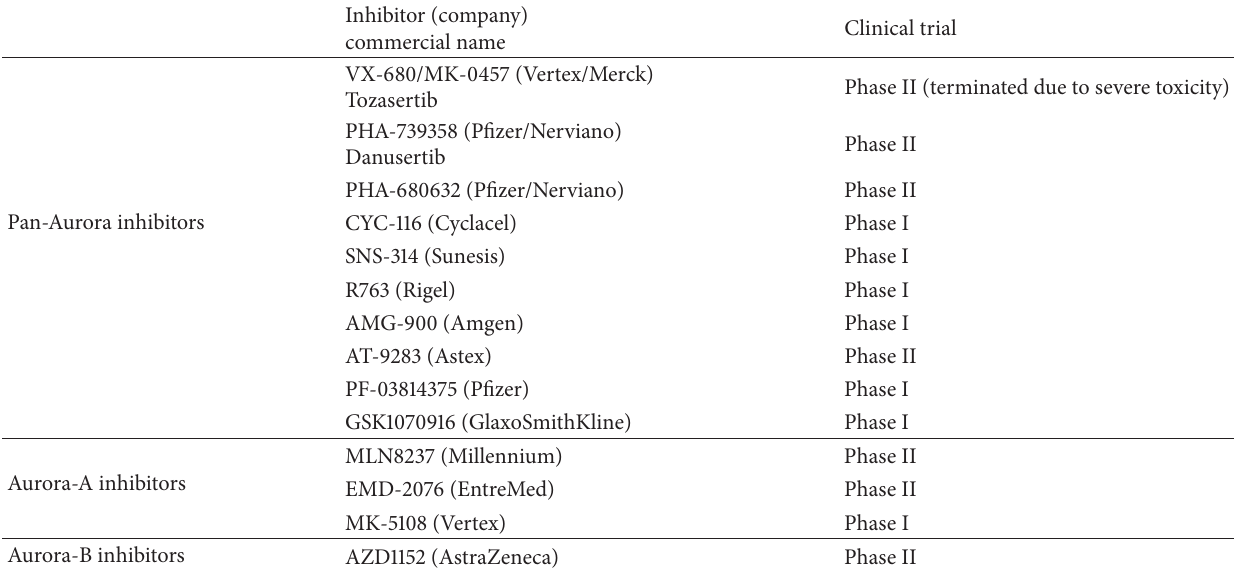
Table 1: Aurora kinase inhibitors in clinical